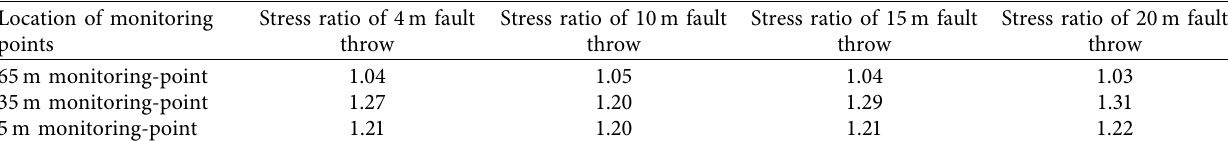
Table 3: Ratio of stress to initial stress when working face is 35 m away from monitoring point. Location of monitoring